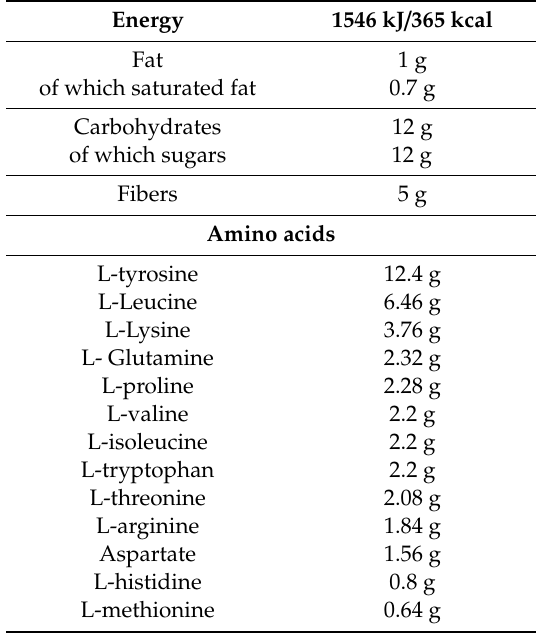
Table 2. Large neutral amino acids (LNAAs): nutritional facts per 100 g of